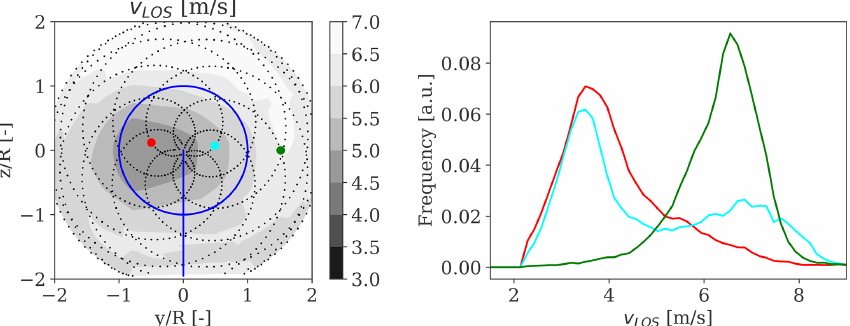
Figure 5. Examples of normalized Doppler LOS velocity spectra measured over a 10min period at 2.5 D in the wake at three different locations – wake centre (red), wake edge (cyan), and wake-free (green) – for an incoming wind speed of 7m/s and ambient turbulence of